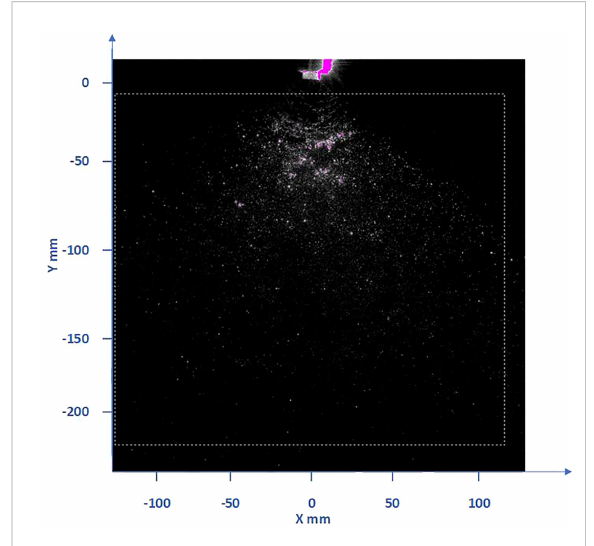
FIGURE 7 Image of droplets distribution in the downwash fl ow fi eld of the nozzle under the rotor. (The red particles are the droplets irradiated by the laser, and the dashed box is the set Mask fl ow fi eld analysis